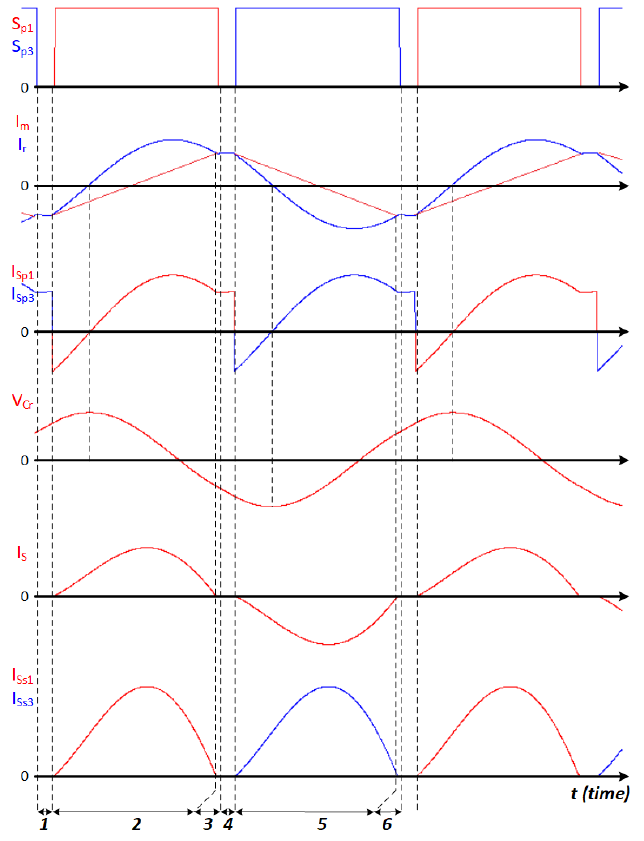
Figure 3. Waveforms of LLC resonant converter and six (6) intervals of